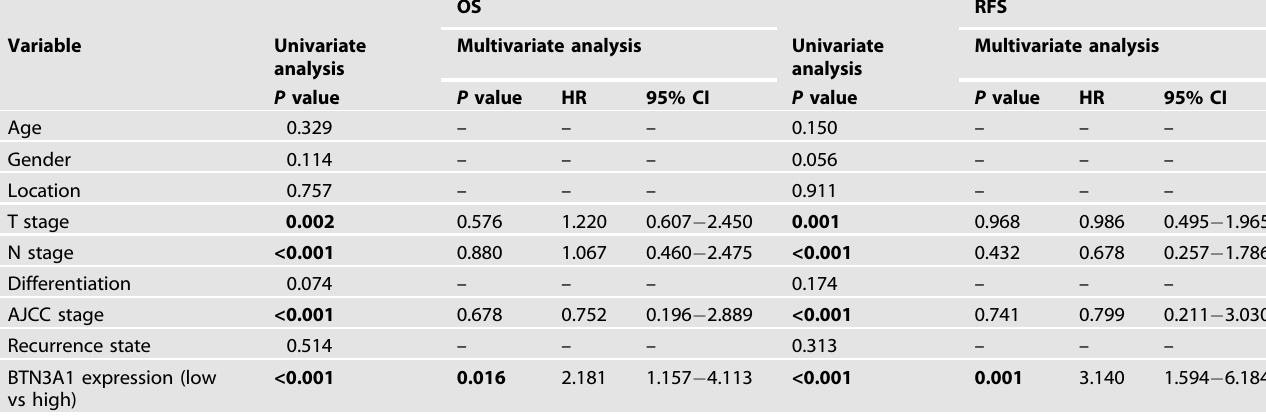
Table 2. Univariate and Multivariate analyses of prognostic factors for OS and RFS in patients receiving radiotherapy with